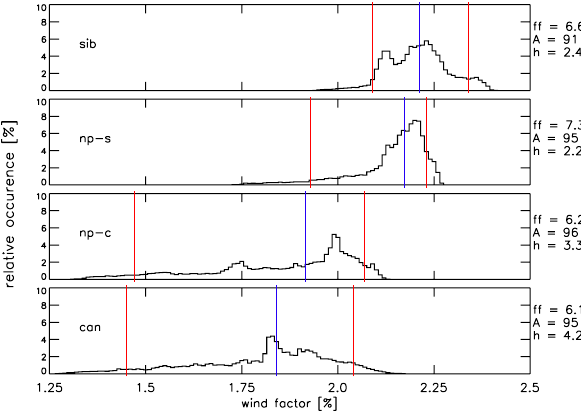
Fig. 13. Frequency distribution of the wind factor within the cyclone radius in four sub-regions of the Arctic Ocean. Red lines mark 5 and 95 percentiles, blue line marks the median. Also given is the mean wind speed ff [m / s], the mean ice concentration A [%] and the mean ice thickness h